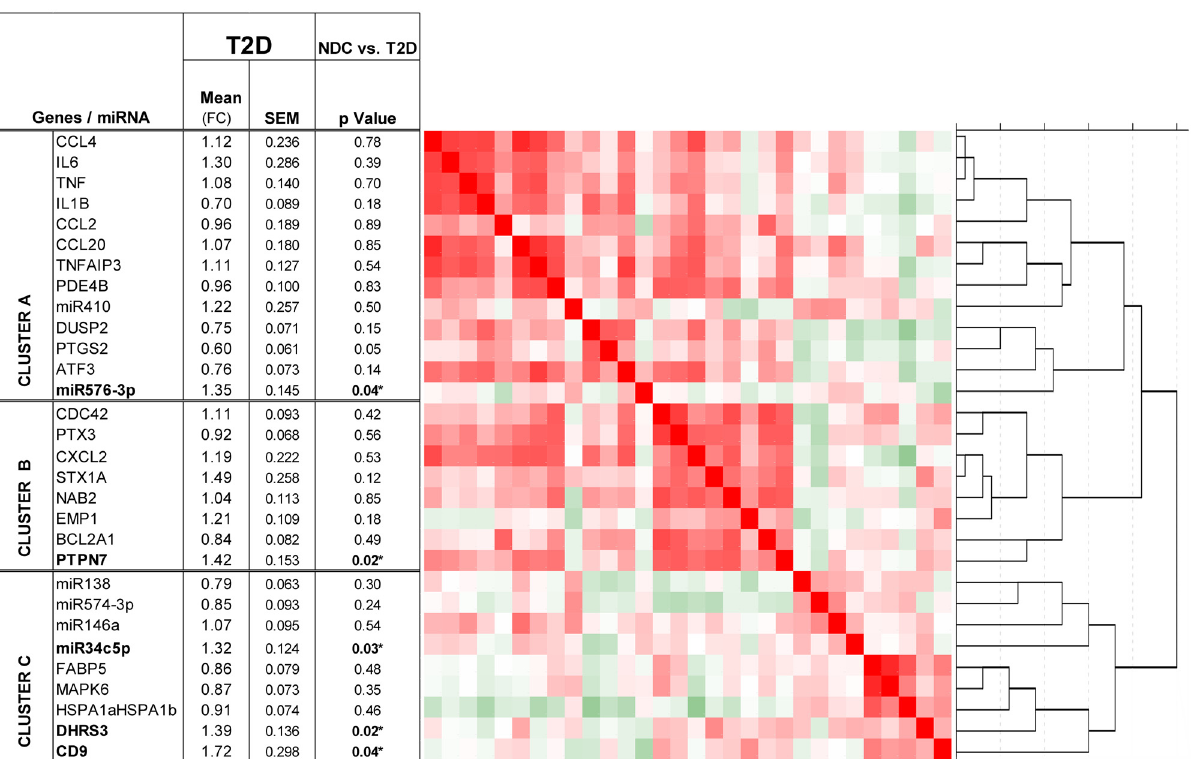
Fig 1. Hierarchical cluster analysis of the tested genes and microRNAs of the monocytes of Ecuadorian type 2 diabetic patients and controls in the validation cohort. On the left, the fold change values between the T2D group and the non-diabetic controls were determined from normalized Ct values (Ct gene/Ct reference gene ABL) by the ΔΔ Ct method (2 − ΔΔ Ct, User Bulletin 2; Applied Biosystems, Foster City, CA). Data were standardized to the non- diabetic control subjects. The fold change of each gene in the non-diabetic control subjects is therefore 1. Differences between groups were tested using t tests for independent samples. This table shows that 2 microRNAs (MiR-34c-5p and miR-576-3p) were significantly higher expressed in the monocytes of the T2D patients compared to non-diabetic controls. Also, 4 genes (of the 24 tested) were significantly different expressed (PTGS2 lower, and CD9, DHRS3 and PTPN7 significantly higher). The heatmap and dendrogram present the result of the hierarchical clustering of the genes. Three major clusters were found: Cluster A contains inflammatory compounds and includes miR-410 and miR-576-3p. Cluster B contains inflammatory compounds and factors involved with migration/differentiation/metabolism; Cluster C only consists of migration/metabolic factors. MiR-138, miR-574-3p, miR-146a and miR-34c-5p formed a sub- cluster within cluster C and strongly clustered together.